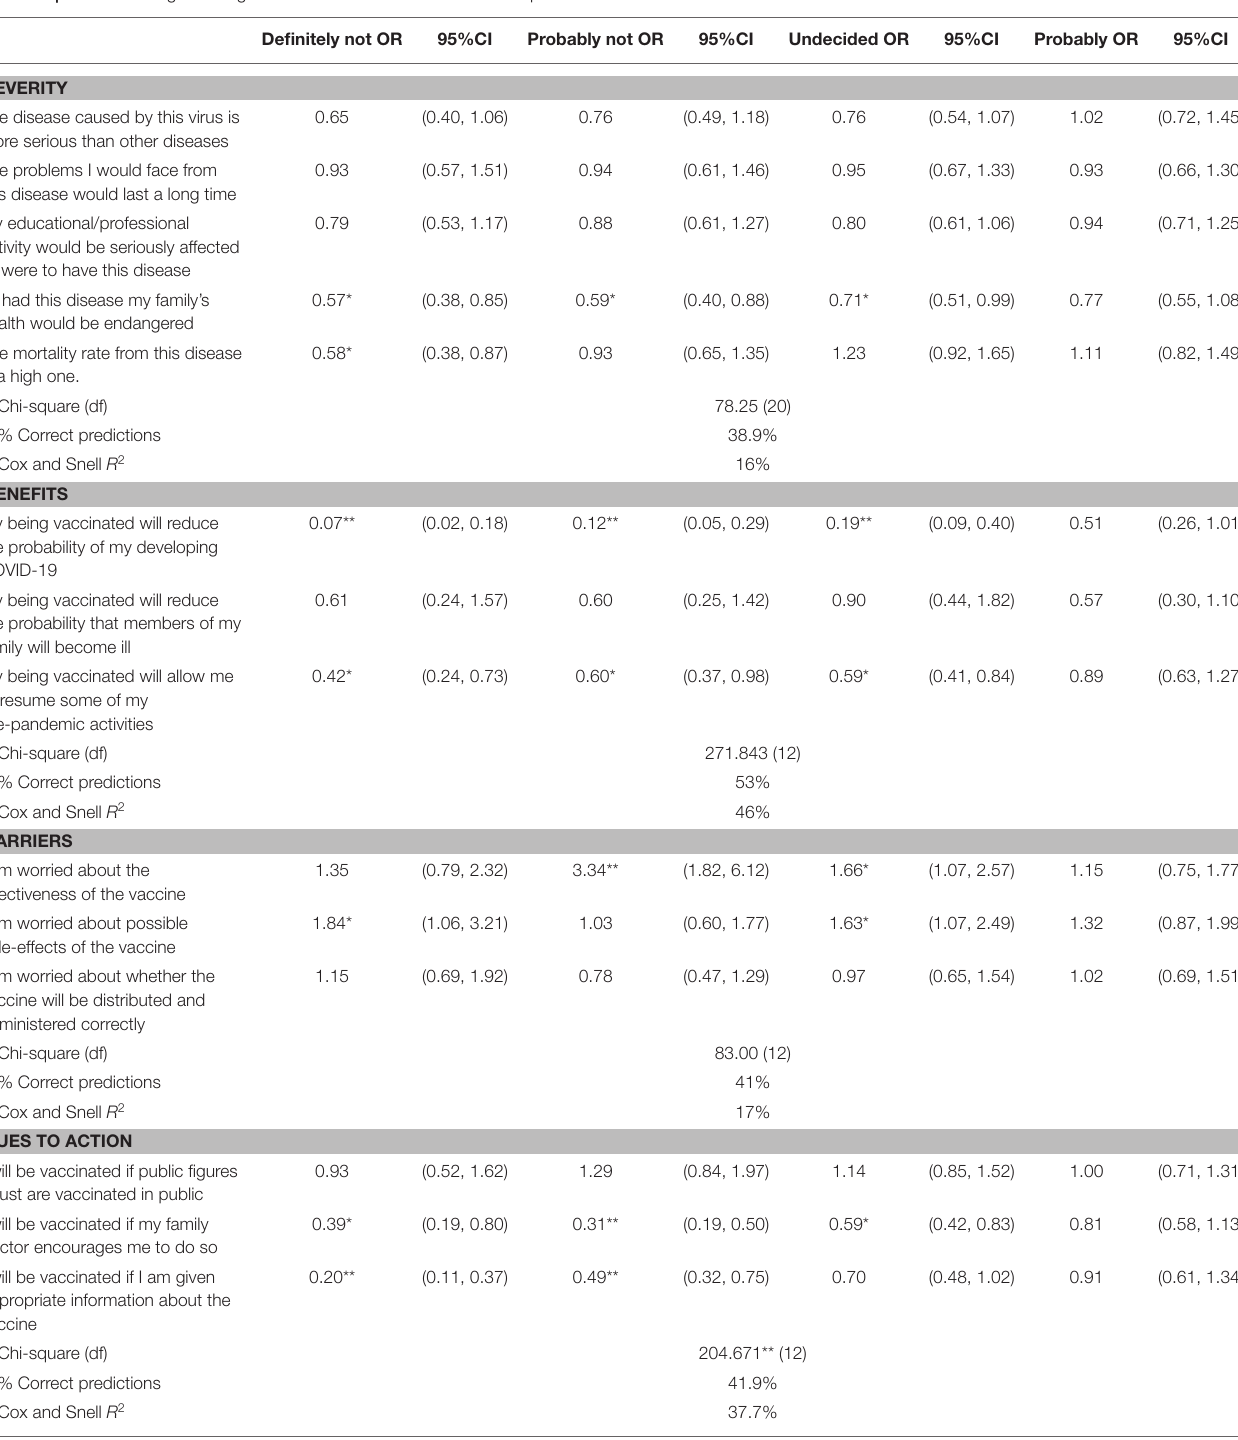
TABLE 5 | Multinomial logistical regressions – individual items of HBM as predictors. Definitely not OR 95%CI Probably not OR 95%CI Undecided OR 95%CI Probably OR